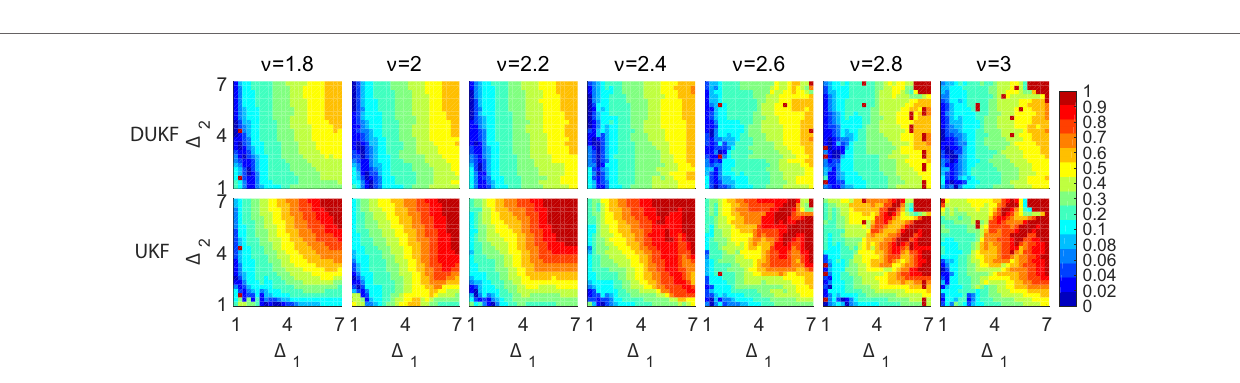
FIGURE 5 | Mean relative error color-plots for the two methods when different initial values are used for the Bouc–Wen parameters.